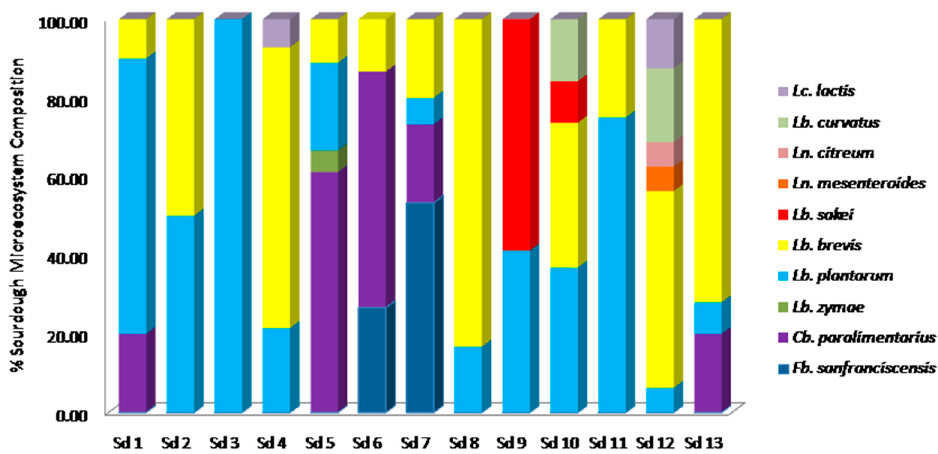
Figure 4. Bacterial microecosystem composition of 13 Greek wheat spontaneous fermented sourdough samples. Sd: sourdough.